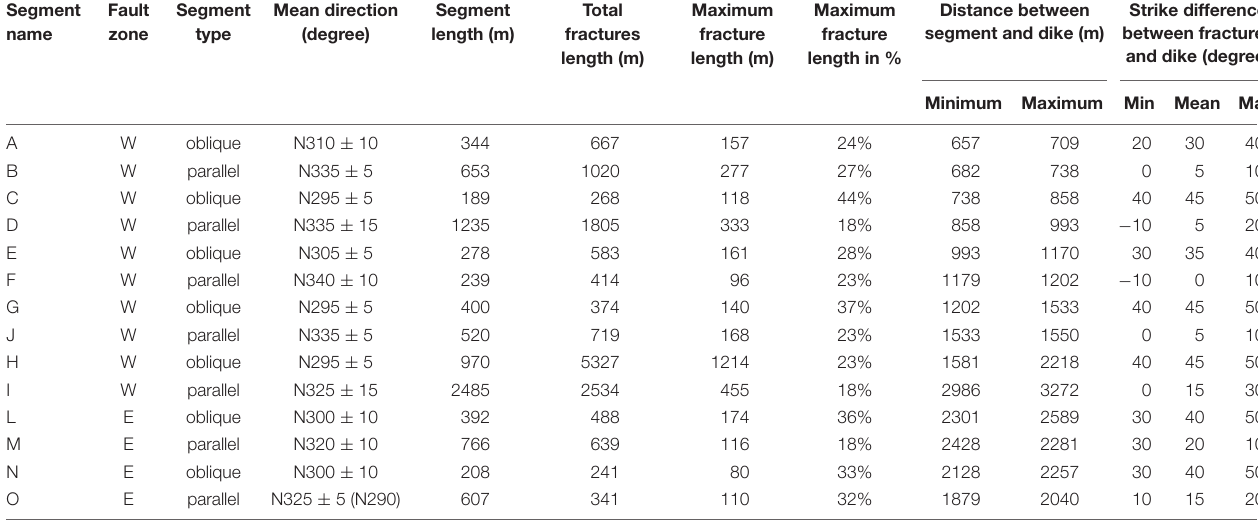
TABLE 1 | Summary of rose diagrams of Figure 1